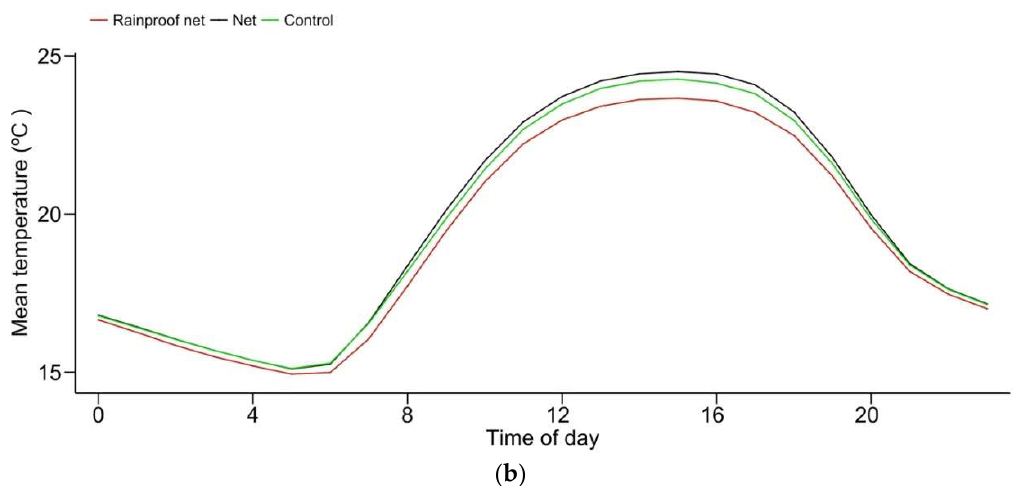
Figure 1. Mean hourly in-canopy air temperature (May–September 2012, 2013, 2015, 2016 and 2017): ( a ) averaged per month over years ( b ) seasonally averaged.